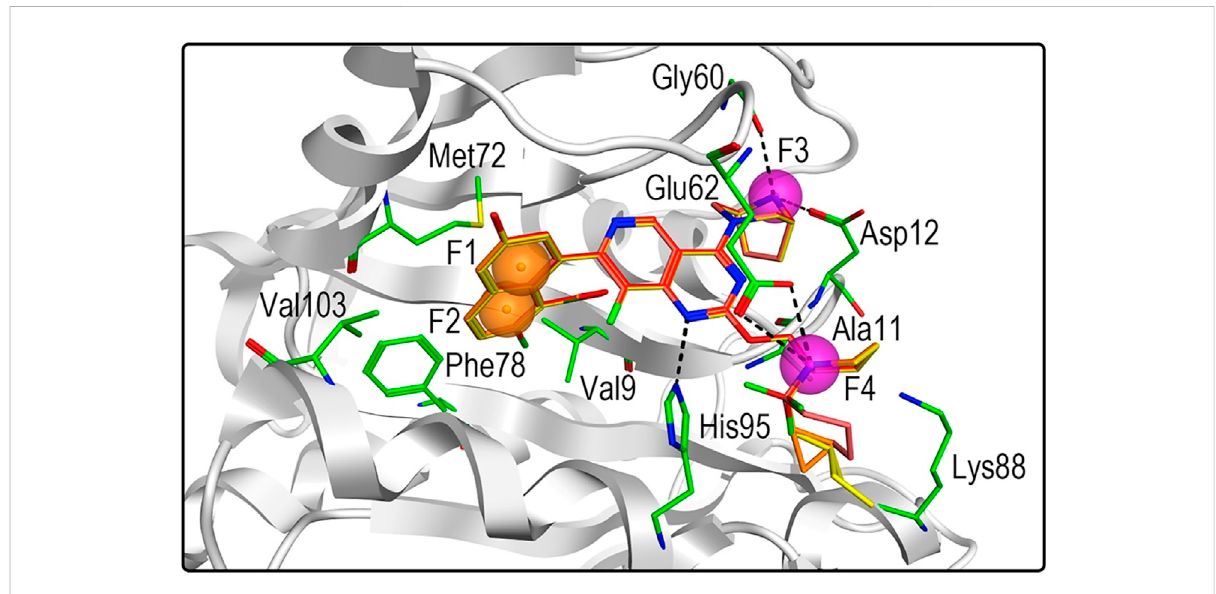
FIGURE 6 Three-dimensional pharmacophore mapping of hit compounds 1 – 4 with the active-site residues in KRAS G12D . Orange spheres correspond to aromatic features (F1 and F2: Aro), and purple spheres represent hydrogen-bond donors (F3 and F4: Don).